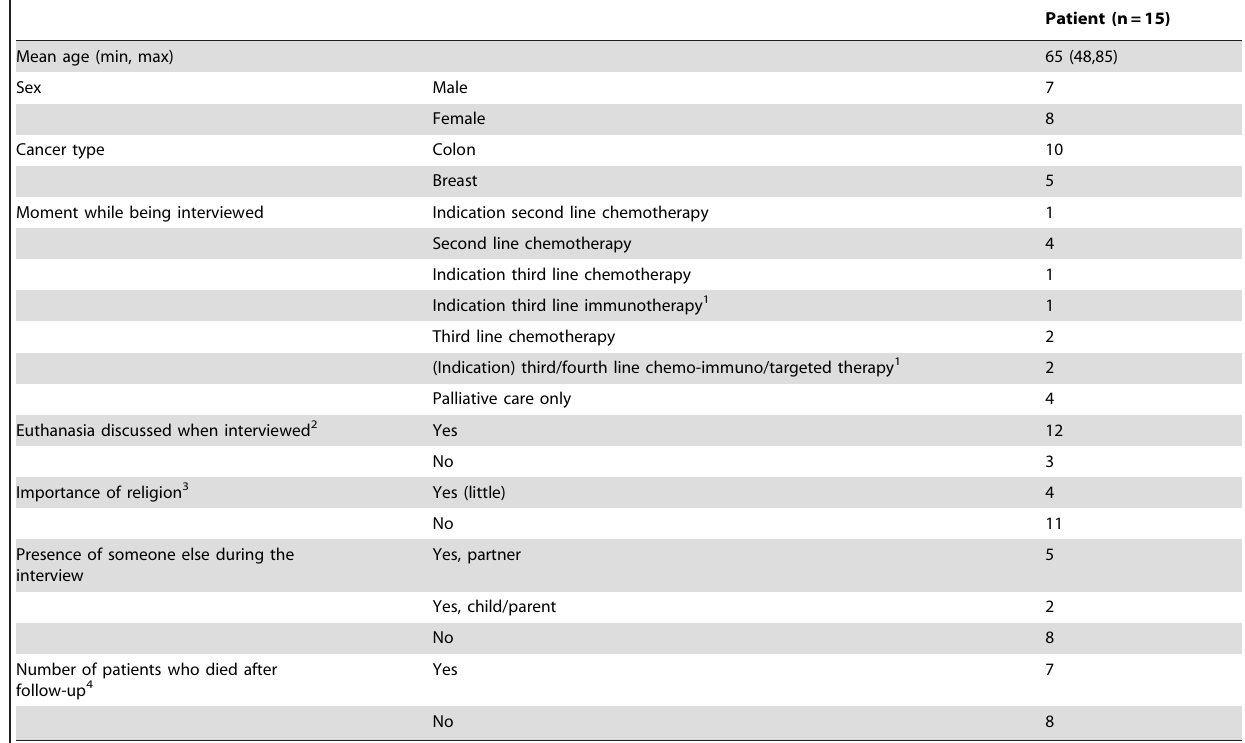
Table 2. Respondent